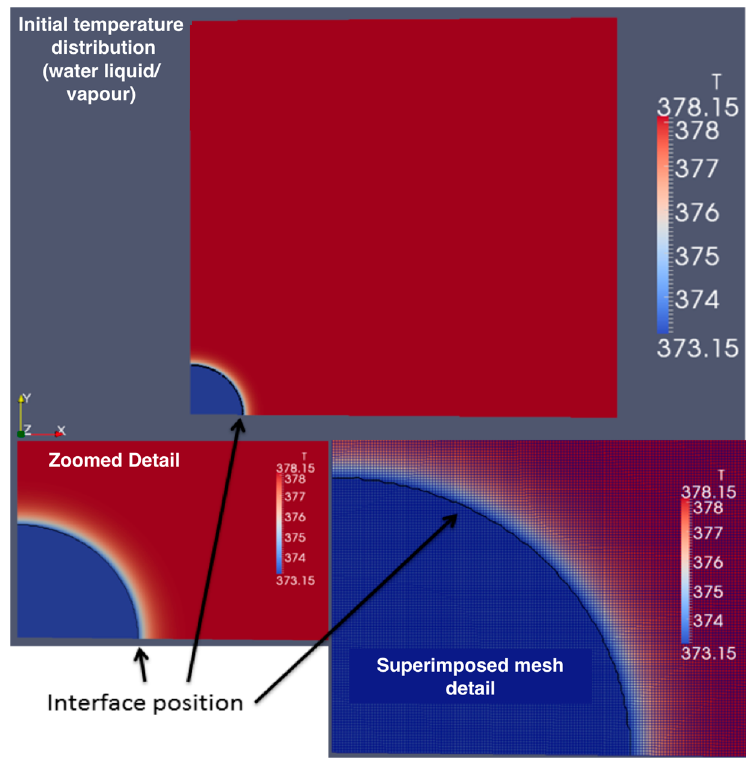
Figure 3. Two-dimensional axisymmetric computational domain, mesh and boundary conditions.